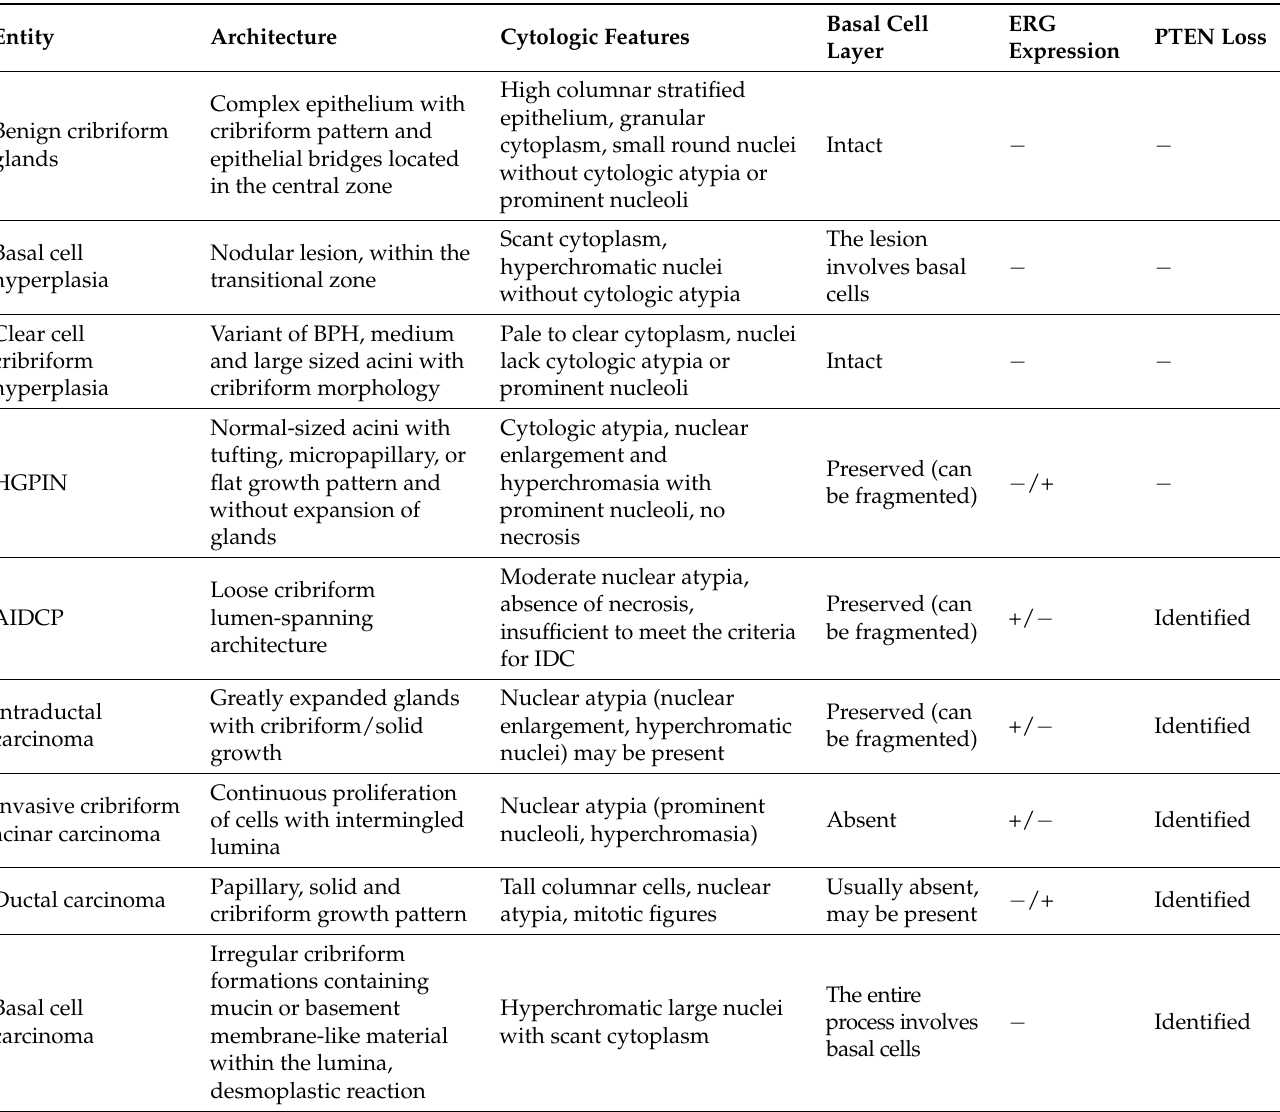
Table 1. Summary of differential diagnosis of entities with cribriform morphology within the prostate